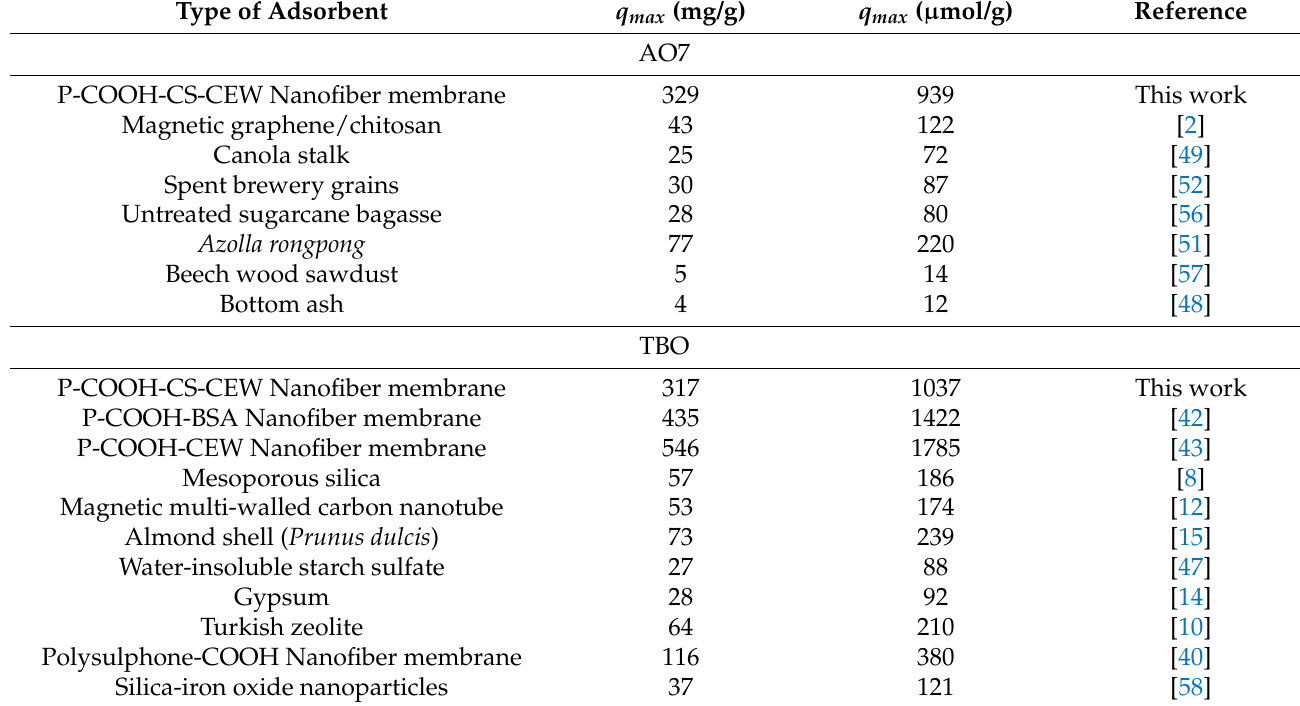
Table 3. Comparison of adsorption capacity of various adsorbers for AO7 and TBO